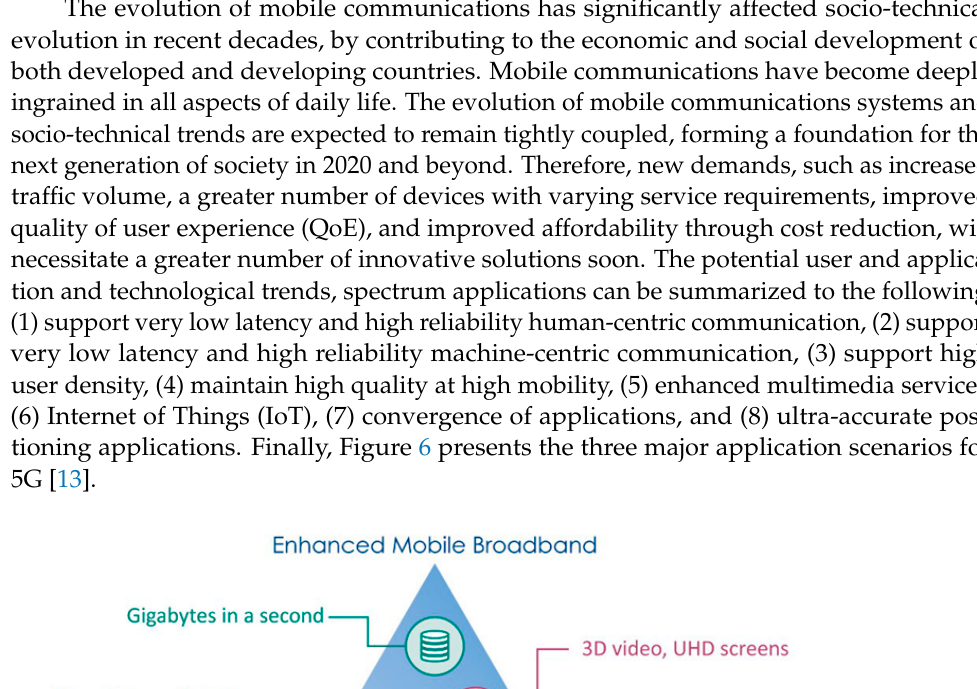
Figure 7. 5G network slices [33].